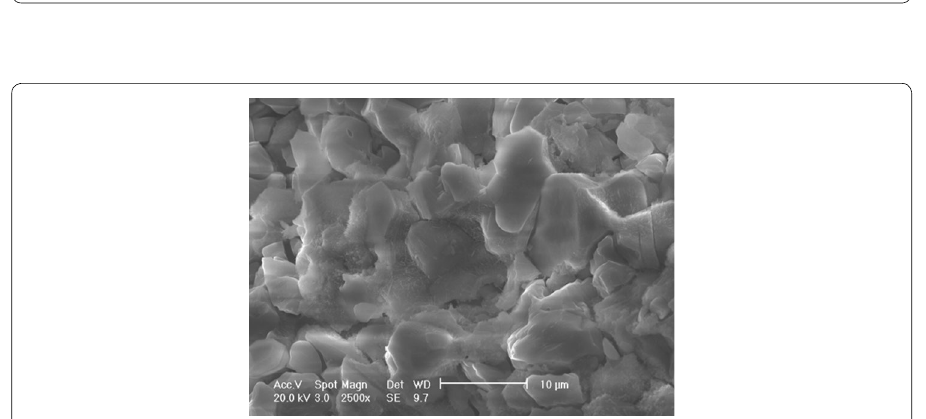
Fig. 17 SEM image showing the particle shape for the